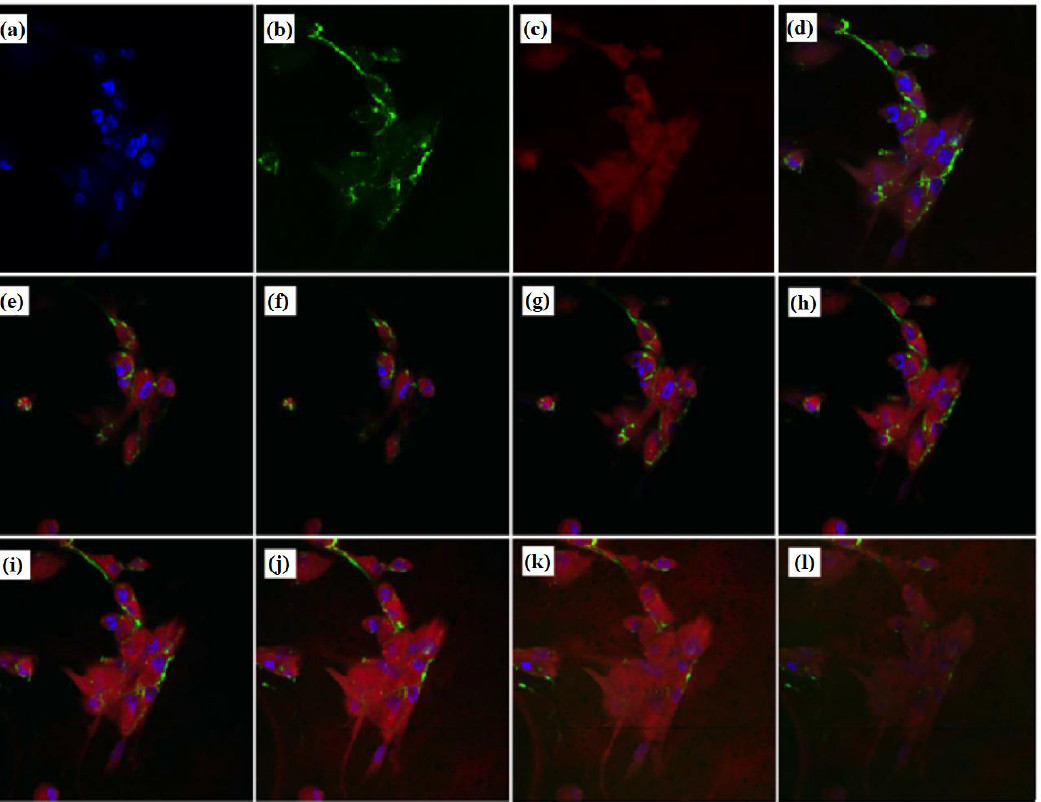
Figure 9. Confocal laser scanning microscopy images of Fbs after incubation with FITC-labelled niosomes for 2 h at 37 °C showing perinuclear accumulation of particles. Nuclei: blue ( a ), FITC- labelled niosomes: green ( b ), cytoplasm: red ( c ), merged images ( d ) confirming uptake of intake niosomes. Eight images of optical sections taken in the vertical axis at interval of 1 µ m from the apical surface ( e – l ) from left to right; top to bottom, depths 0, 1, 2, 3, 4, 5, 6 and 7 µ m, demonstrating particle internalisation. Magnification (600 ×